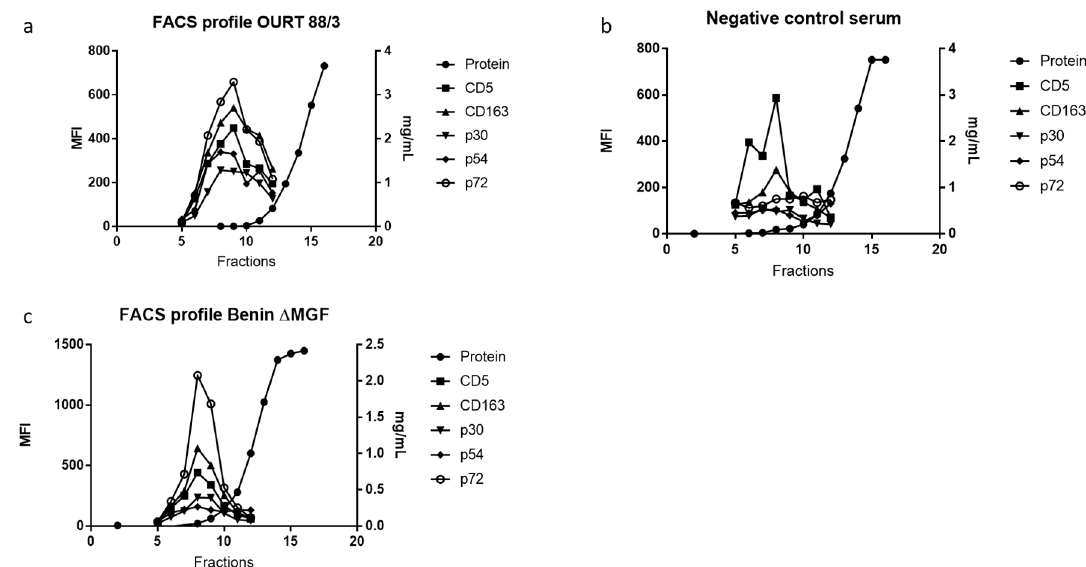
Figure 3. FACS analysis of EV-enriched fractions derived from infected and control animals. ( a ) EVs from representative sera of an infected animal with OURT 88/3 at 24 days post infection, ( b ) EV profiles from a representative of uninfected swine sera, ( c ) EV FACS profile from a representative animal infected with Benin Δ MGF virus. In all samples, molecular markers CD5 and CD163 were used as control markers for EVs and three different viral proteins were evaluated (p30, p54 and p72).